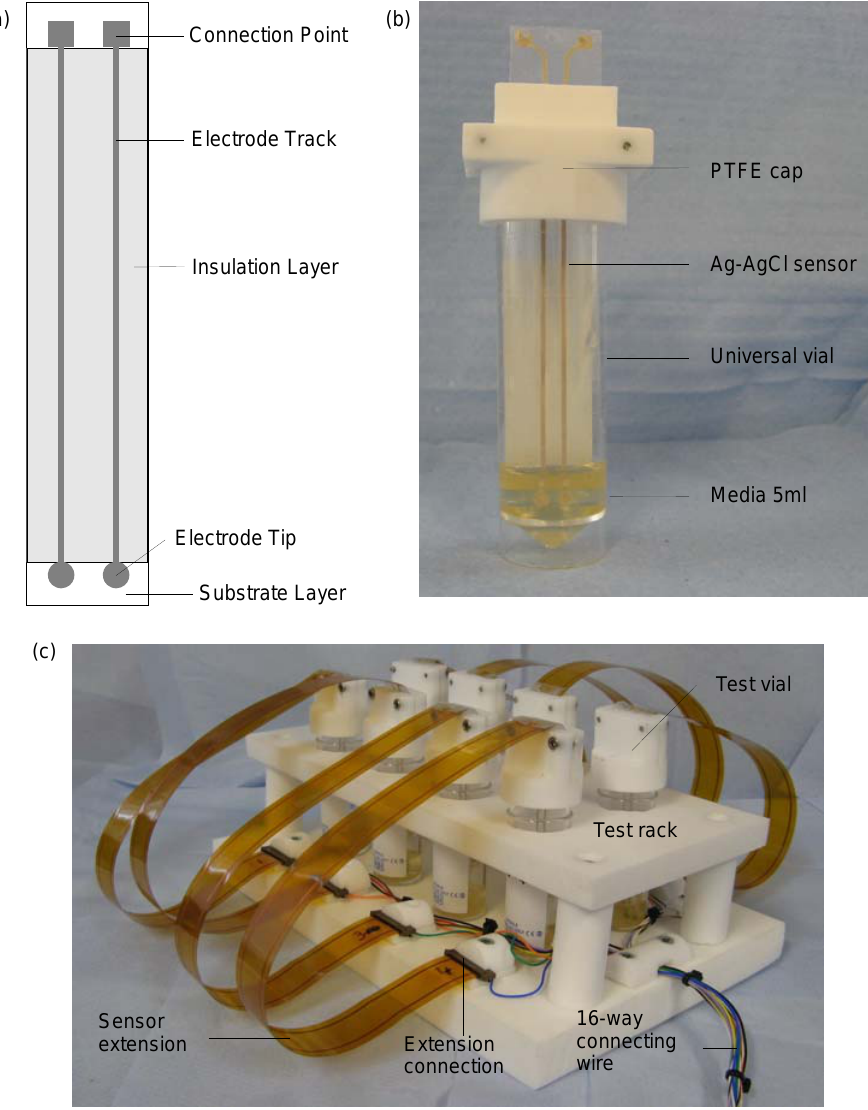
Figure 1. ( a ) The basic design of the screen-printed sensors. ( b ) The bacterial suspension test vial comprised a 30 mL universal vial, 5 mL of media, a specifically designed polytetrafluoroethylene (PTFE) cap and a Ag-AgCl sensor. ( c ) The test rig to allow parallel measurement of up to eight bacterial suspension test